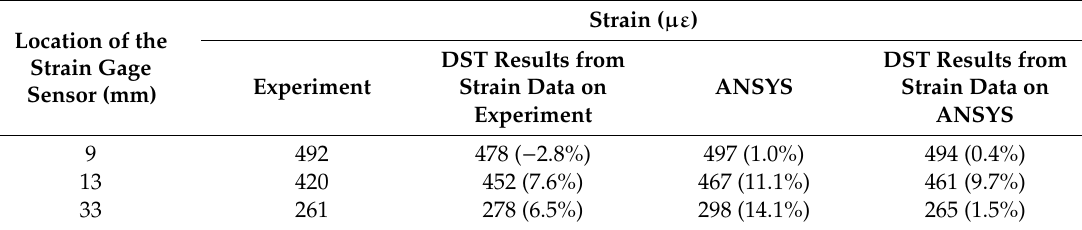
Figure 13. Strain estimation results using the DST matrix (multi-material). Table 7. Strain estimation results using the DST matrix (multi-material).